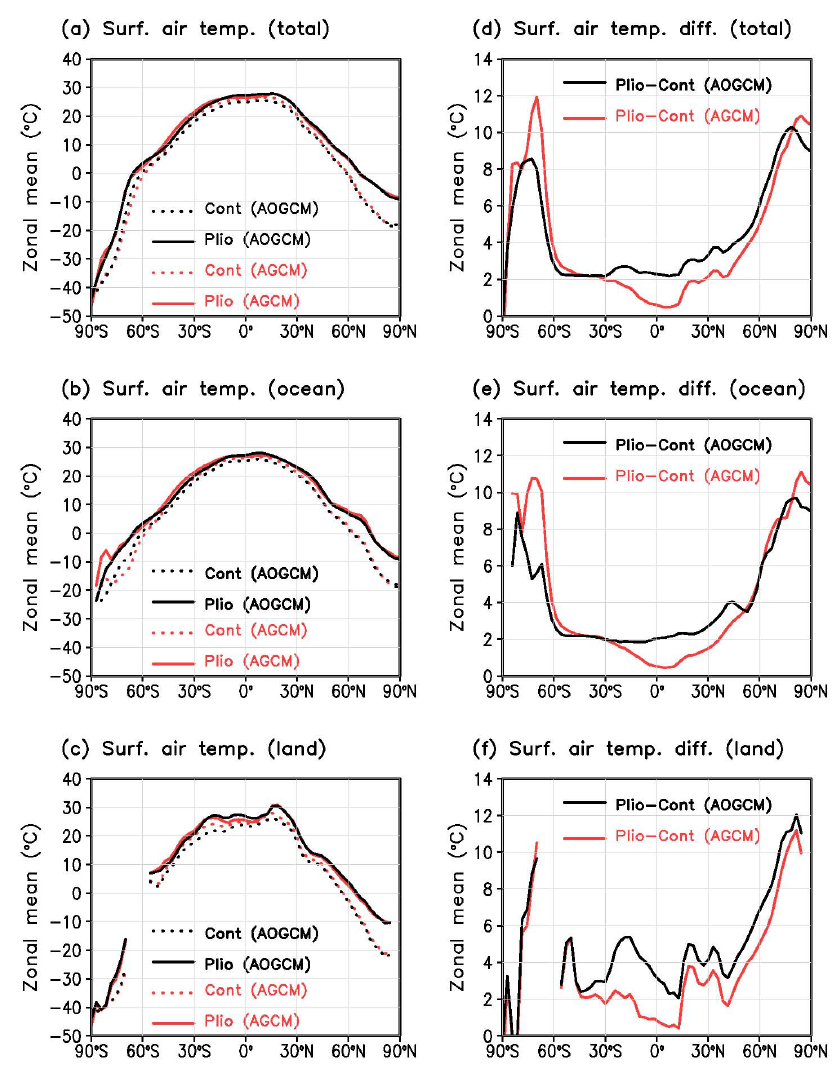
Fig. 8. Zonal mean surface air temperature (a, b, c) for the control (dotted lines) and mid-Pliocene (solid lines) experiments, and their differences (d, e, f) . Values for the AGCM and AOGCM are denoted in red and black, respectively. wavelength bands are modified according to the new vegeta- tion distribution (Table